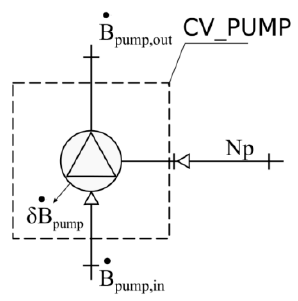
Figure 2. Exergy model for a reservoir.